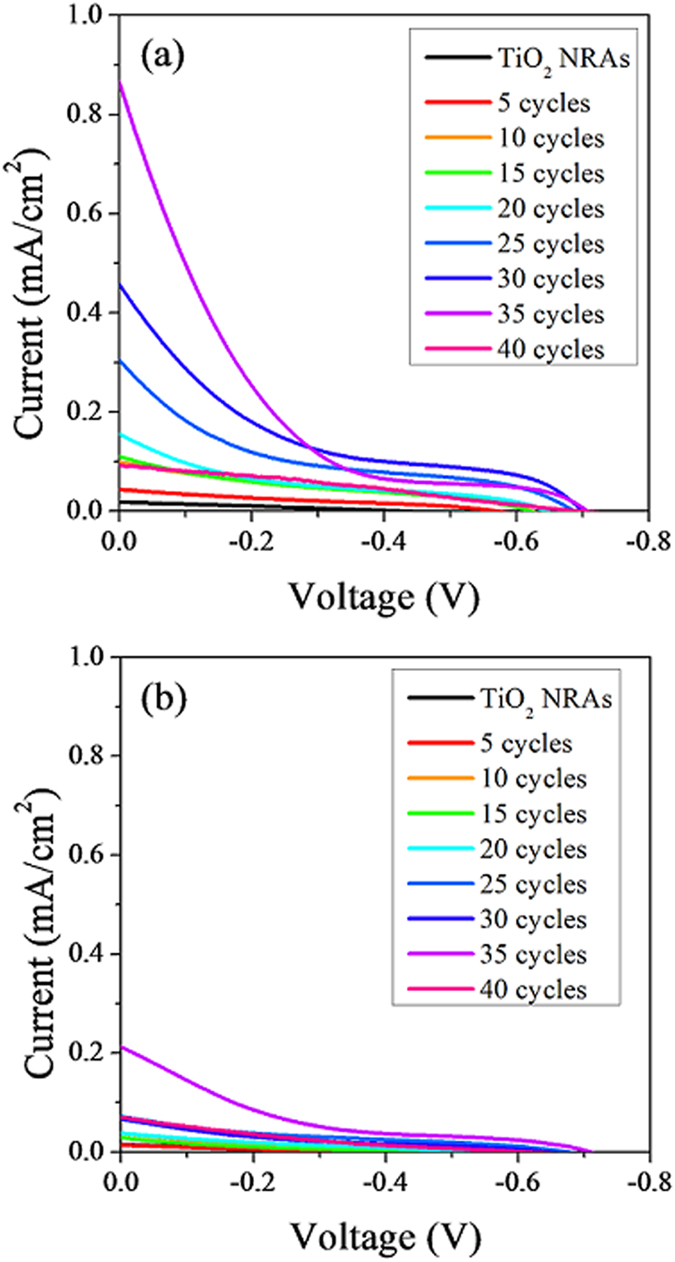
Photocurrent density-voltage curves of TiO2 NRAs and Ag2S-coupled TiO2 for various cycles under(a) visible light irradiation and (b) dark condition.